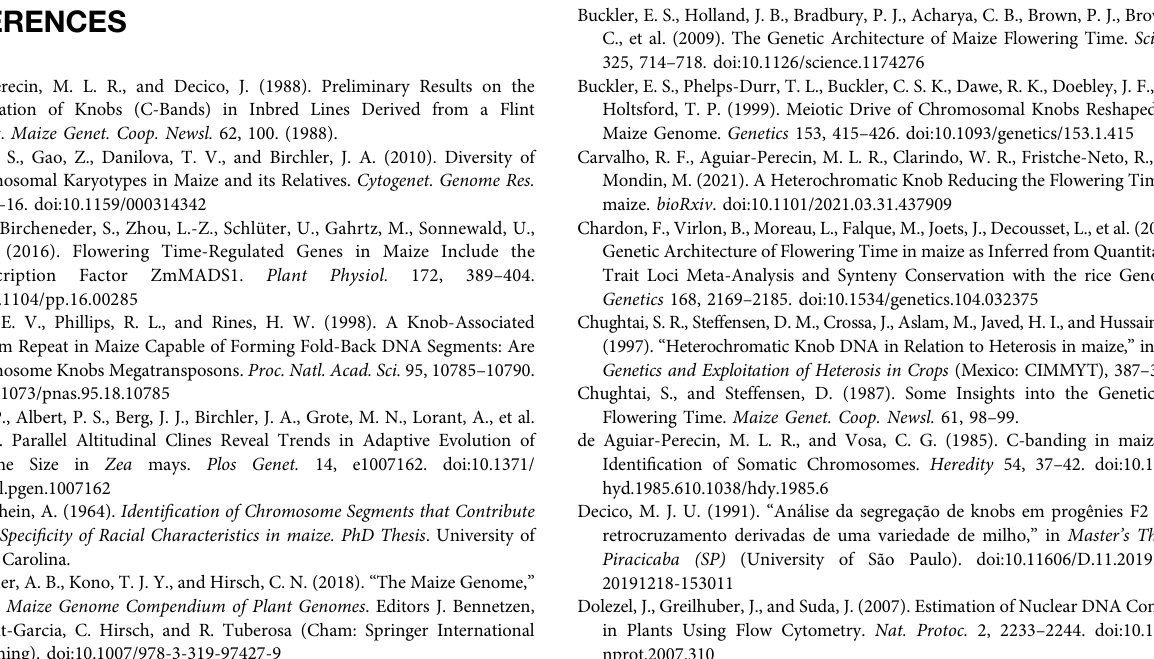
Supplementary Figure S1 | Flowering time and Genome Size versus knob condition. Boxplots show the comparison between male and female fl owering time (days) and genome size (picograms) regarding heterozygous knobs or homozygous knobs. The boxes indicate the fi rst quartile (lower line), the second quartile or mean (central line), and the third quartile (upper line). Additionally, the whiskers represent the standard deviation with the dots as the outliers. Supplementary Figure S2 | QQ-plot and Manhattan plot of GWAS for Genome size. Plots characterize the allele substitution effect. Signi fi cant associations are not found. The x axis shows the knobs K3L, K5L, K7S and K9S. The y axis shows the logarithm of the value of signi fi cance. SupplementaryFigureS3| QQ-plot ofGWASof fl oweringtime.Plotscharacterize the allele substitution effect for (A) male fl owering (mf) and (B) female fl owering (ff) time. The dots represent the knobs K3L, K5L, K7S and K9S, respectively. SupplementaryFigureS4| QQ-plot ofGWASof fl oweringtime.Plotscharacterize thedominanceeffect for(A)male fl owering(mf)and (B)female fl owering(ff) time.The dots represent the knobs K3L, K5L, K7S and K9S